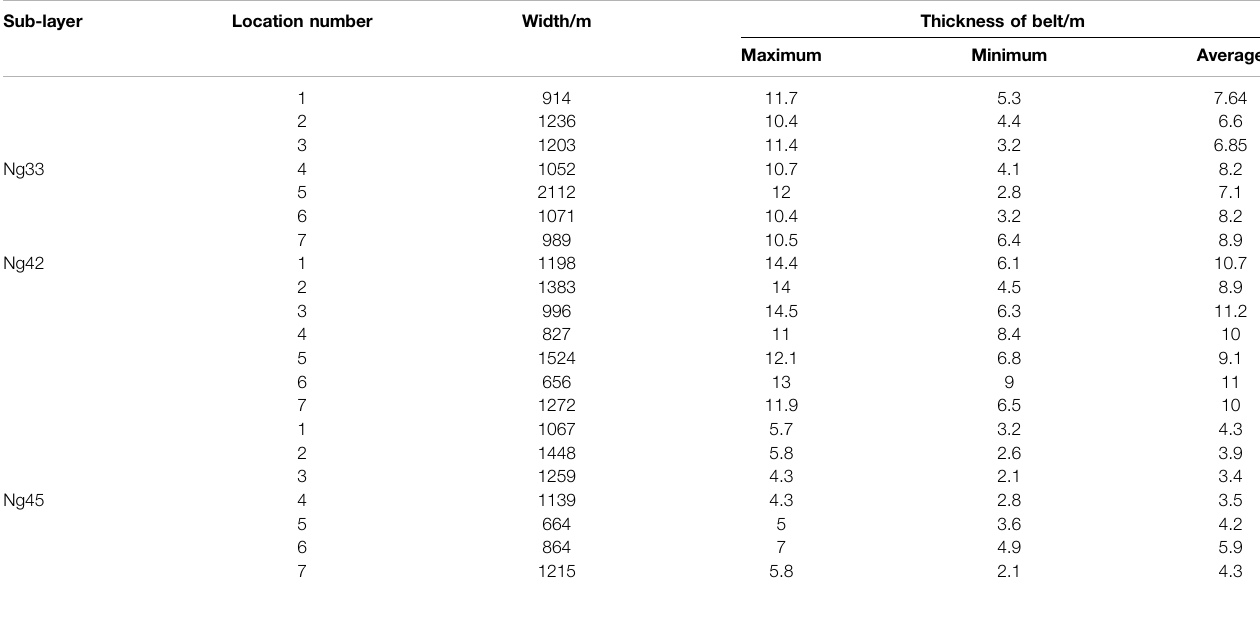
TABLE 1 | Statistical table of width and thickness parameters of meander-river belt in different sub-layers. Sub-layer Location